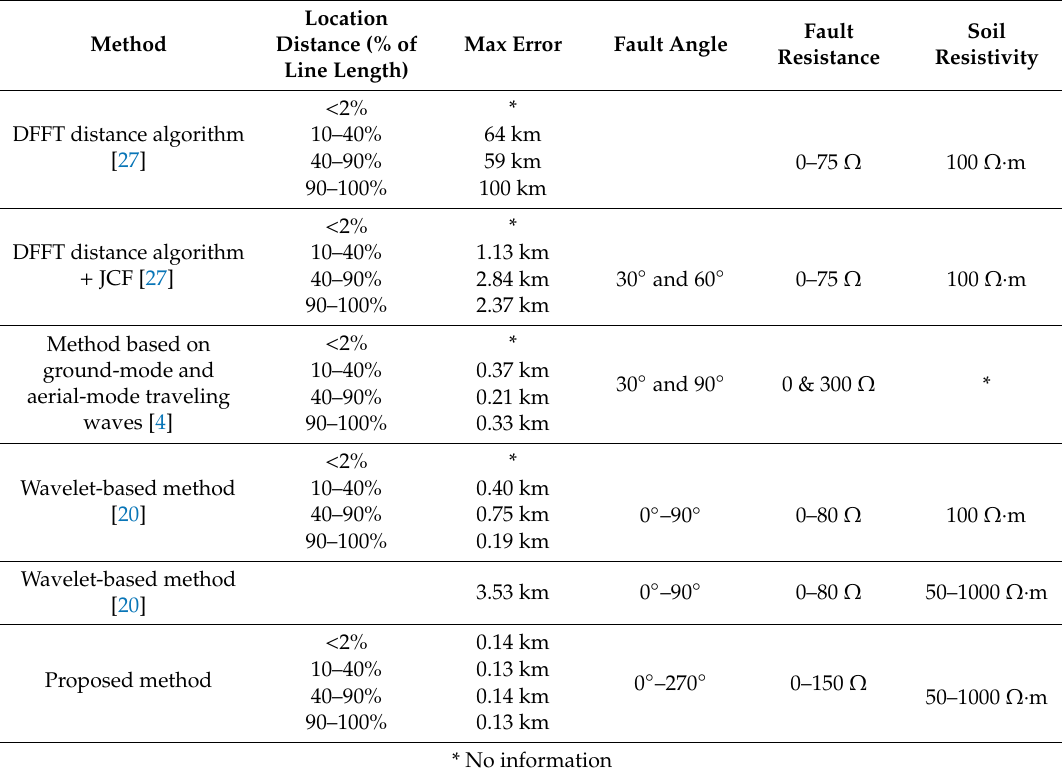
Table 5. Comparison of the proposed method with di ff erent single-ended